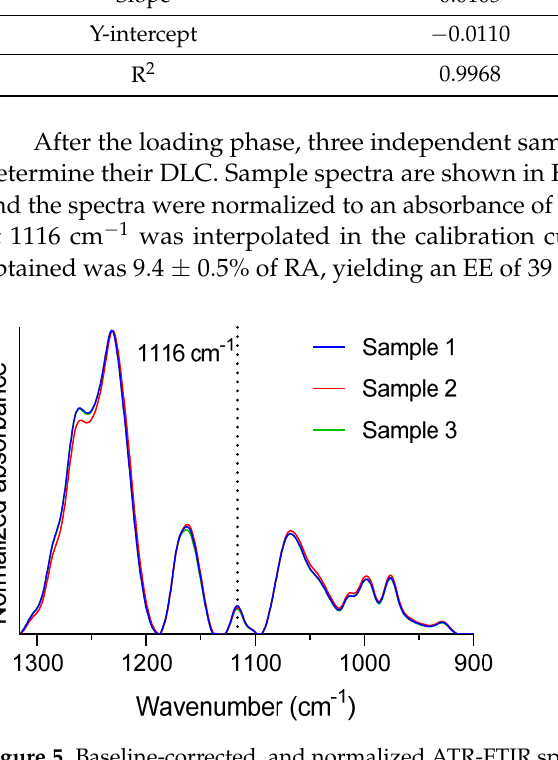
Figure 5. Baseline-corrected, and normalized ATR-FTIR spectra of three RA-SFN samples.